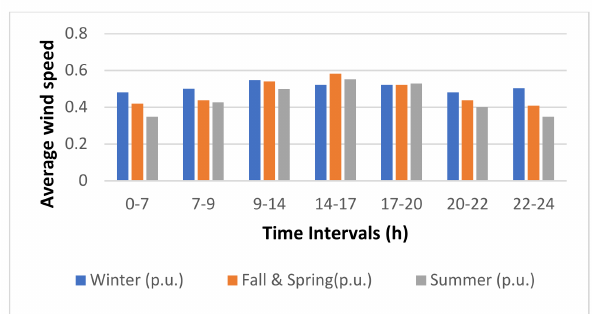
Figure 3. For different seasons. By this consideration, the only variable that should be defined is the capacity needed for supplying the demand in a power network. Thus, the desired particle is as